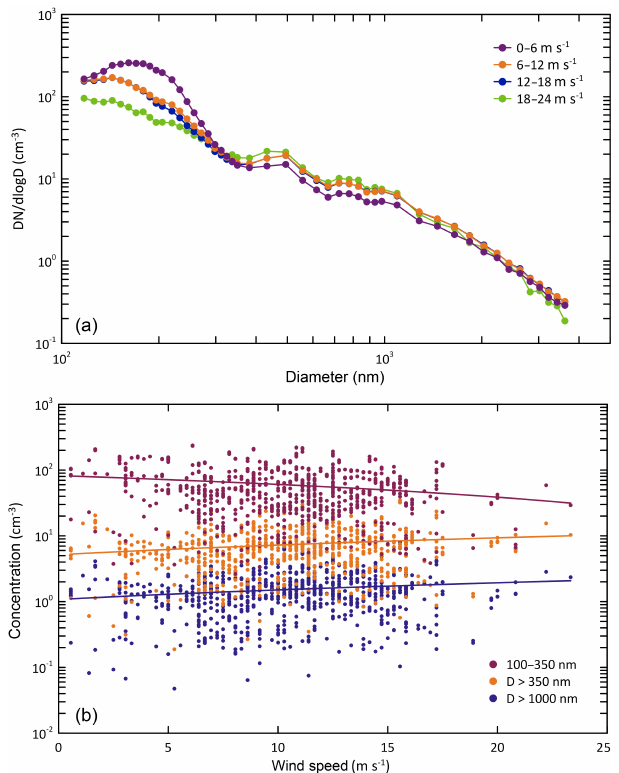
Figure 2. (a) Summer clean MBL size distributions in 6ms − 1 wind bands, medians of hourly data. (b) Cumulative concentration as a function of wind speed for accumulation/CCN mode (117–350nm) and for D >350 and D >1000nm.